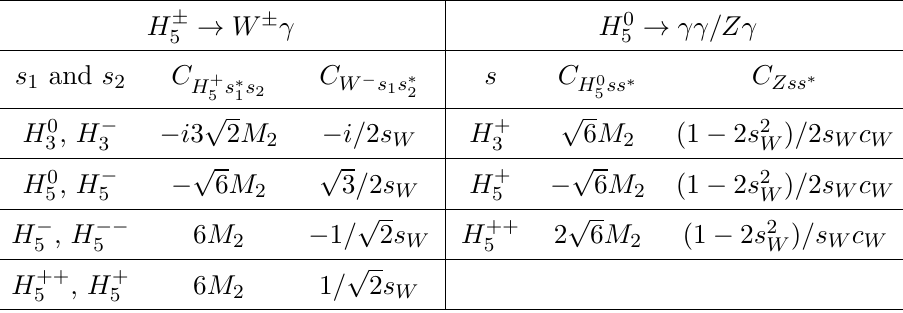
W (cid:6) (cid:13) and H 0 (cid:13)(cid:13); Z(cid:13) decays and 5 ! 5 ! !